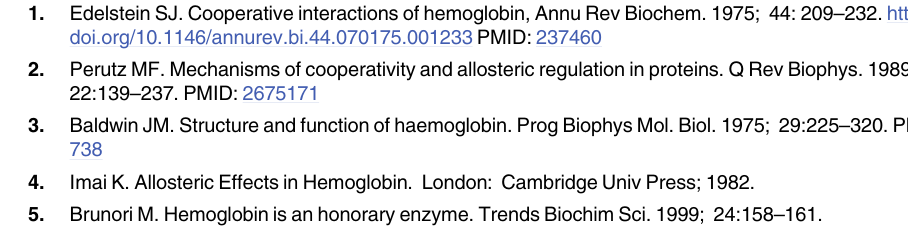
S1 Table. ‘TES strategy’-derived MWC parameters of human hemoglobin oxygen satura- tion curves of the physiological dataset a . a The table reports the physiology-sound solution set from the TES strategy applied to different hemoglobin physiological datasets. b The hemo- globin physiological datasets analyzed in the current study were complied from the meta-anal- ysis described in ref. [33]. Values for LK R4 and Lc 4 were reported therein, however, with no error bars indicated. c Hill coefficients at half-saturation calculated based on the derived K , R K T , and L parameters (see text and Methods section). d Hill coefficient at half-saturation derived upon fitting hemoglobin oxygen saturation data to the Hill equation, as reported in ref. [33]. e data analyzed and presented in Fig 2. c data analyzed and presented in S3 Fig. S2 Table. ‘Global fitting’-derived MWC parameters of human hemoglobin physiological dataset saturation curves a . a The MWC allosteric parameters for the hemoglobin pH, CO 2 and 2,3-BPG physiological datasets were obtained using global fitting analysis, as described in the main text body and Methods section. b The values for L are apparent, as they are deter- mined in the presence of varying concentrations of the same effector. c Hill coefficients at half- saturation calculated based on the K , K , and L MWC parameters (see text and Methods sec- R T tion). d Hill coefficients at half-saturation derived upon fitting hemoglobin oxygen saturation data to the Hill